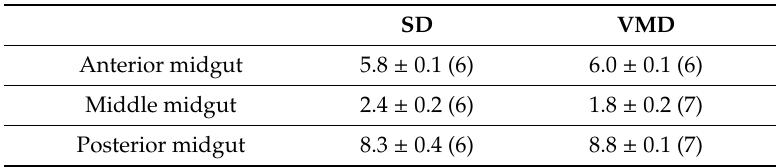
Table 3. pH values in the lumen of H. illucens midgut regions. Mean ± s.e.m., number of replicates in parenthesis. No statistically significant di ff erences were recorded among diet groups for each midgut region (unpaired t